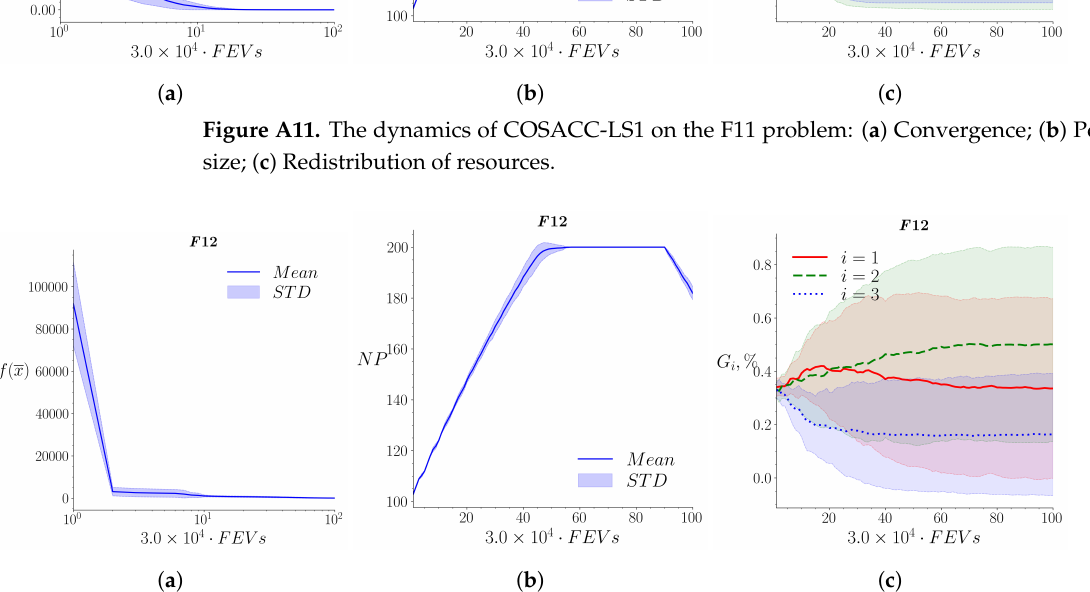
Figure A12. The dynamics of COSACC-LS1 on the F12 problem: ( a ) Convergence; ( b ) Population size; ( c ) Redistribution of resources.